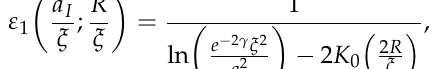
(cid:16) (cid:17) a I ; R to the energy of 3D dilute ξ ξ = ± ξ